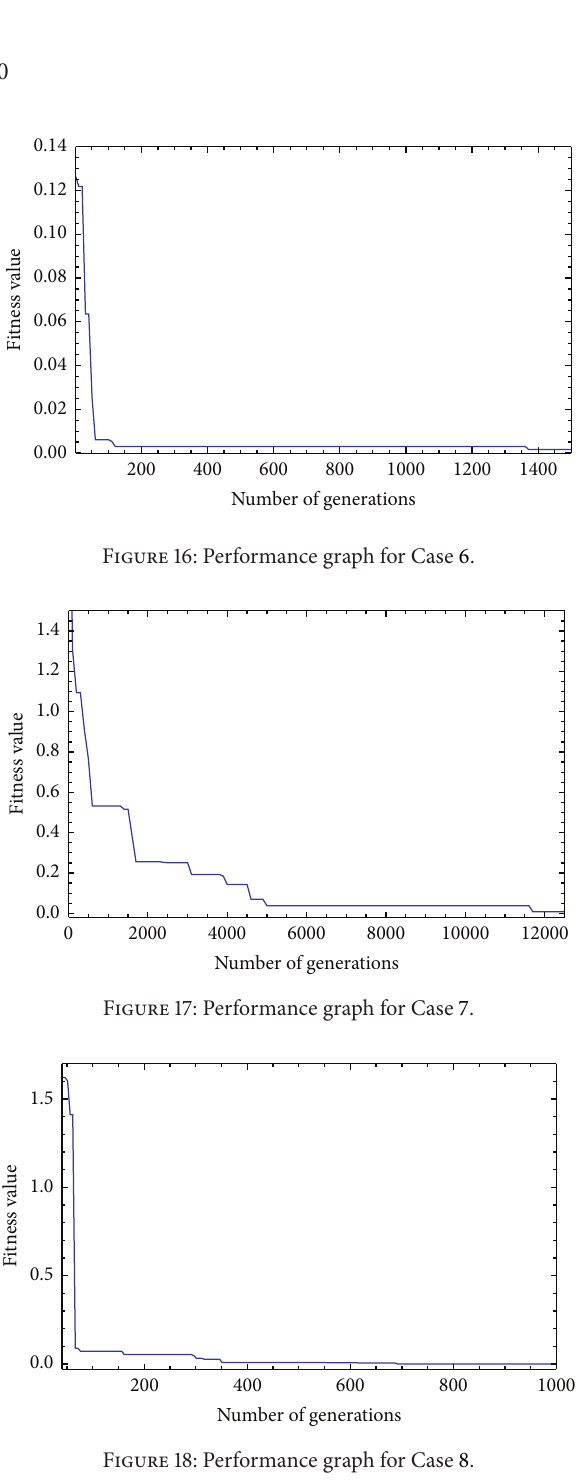
Figure 18: Performance graph for Case 8.